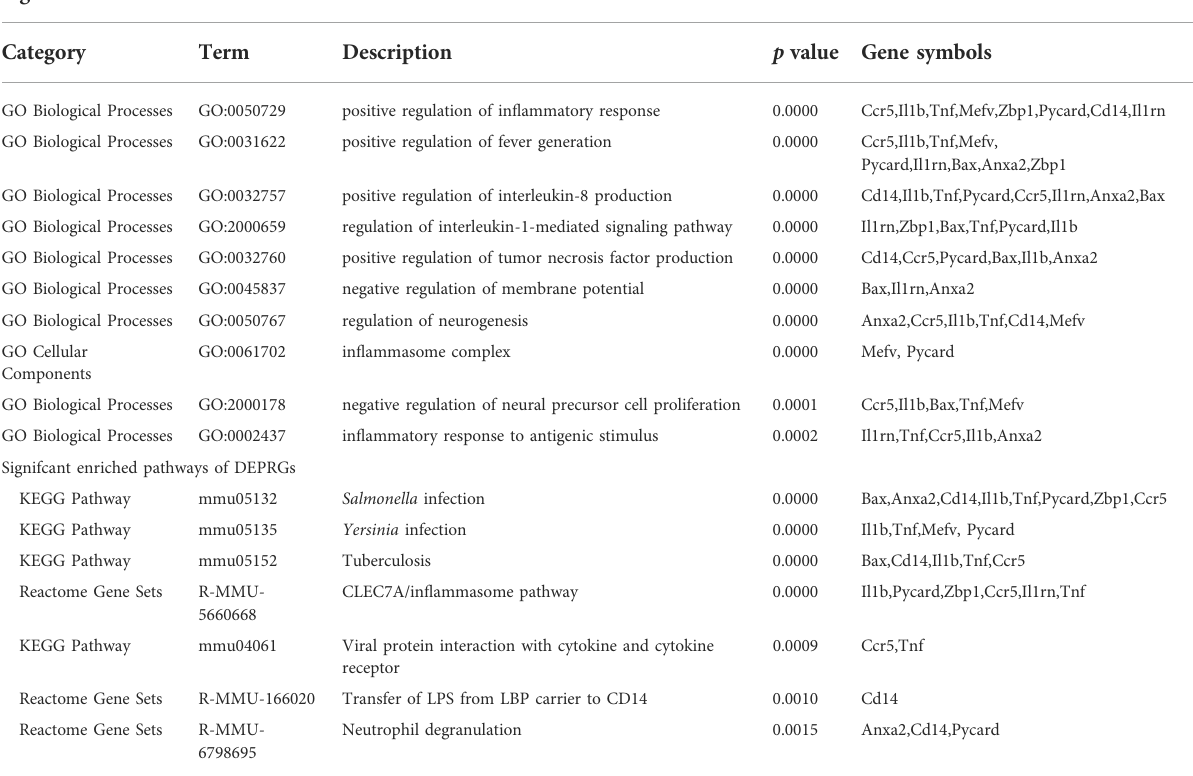
TABLE 4 Functional enrichment analysis of differentially expressed pyroptosis-related genes